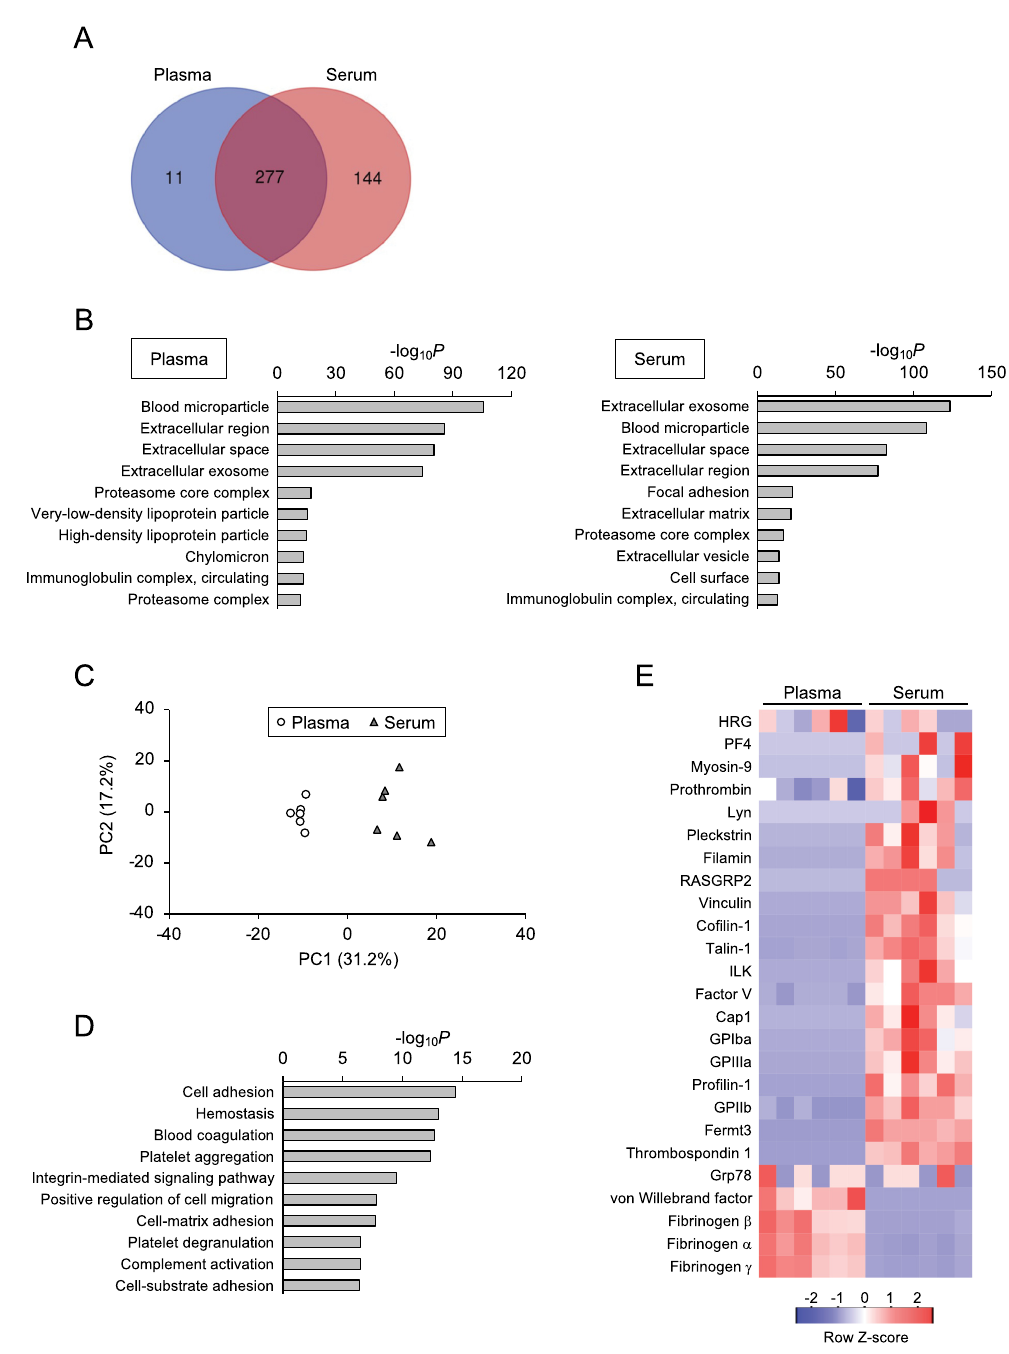
Fig 3. Proteomic analysis demonstrates substantial enrichment of platelet-associated proteins in serum EVs. (A) Venn diagram of the proteins identified in the sEV fractions derived from plasma and serum (n = 6) by LC-MS/MS analysis. (B) GO cellular component of the proteins identified in plasma EVs and serum EVs. P -values from the modified Fisher’s exact test are shown as bar graphs. (C) Principal component analysis of the dataset of proteins identified in plasma EVs and serum EVs. (D) GO biological process of the proteins that are upregulated or exclusively detected in serum EVs. (E) Heat map analysis of proteins with platelet-associated GO terms that were identified in our LC-MS/MS analysis.